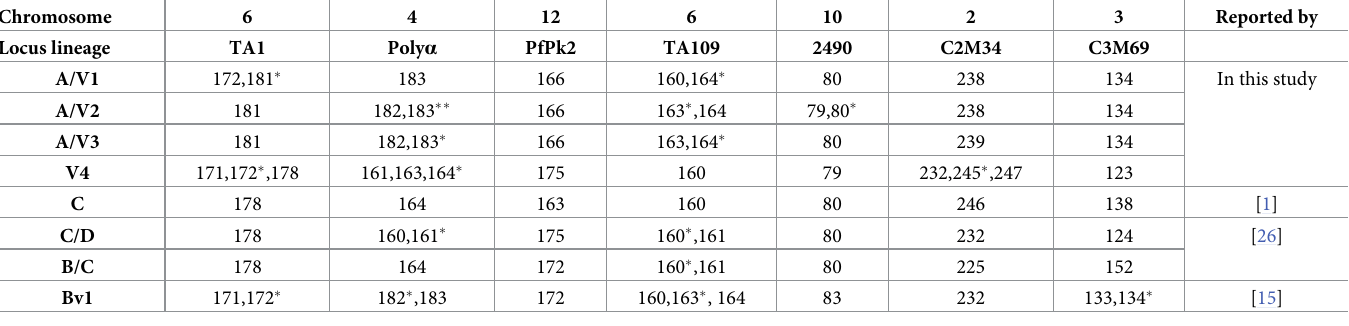
Table 3. Neutral microsatellite marker (TA1, Poly α , PfPk2, TA109, 2490, C2M34 and C3M69) profiles for Peruvian samples. The table shows the microsatellite loci sizes obtained for each of the eight haplotypes lineages from samples collected.